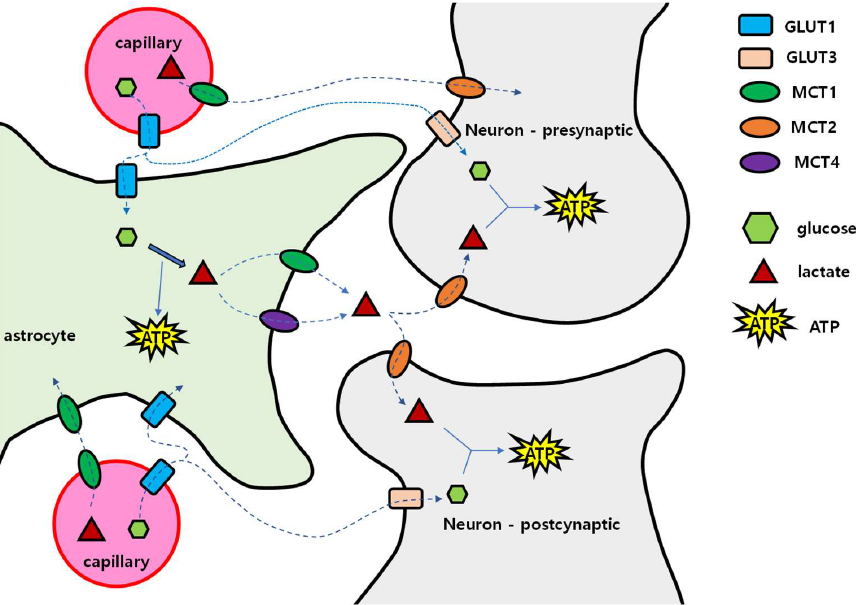
Figure 5. Glucose and lactate delivery to nerve cells. Glucose is transported from capillaries to astrocytes via GLUT1. After entering the astrocyte, glucose is metabolized to lactate, then lactate is transported out into the interstitium via MCT1 and MCT4. Lactate enters into presynaptic and postsynaptic neurons via MCT2 and is used for energy metabolism after being converted into pyruvate. Glucose can also enter neurons directly via GLUT3. Blood capillary lactate enters into astrocytes via MCT1 and into neurons via MCT2. GLUT: glucose transporters; MCT: monocarboxylate transporter.